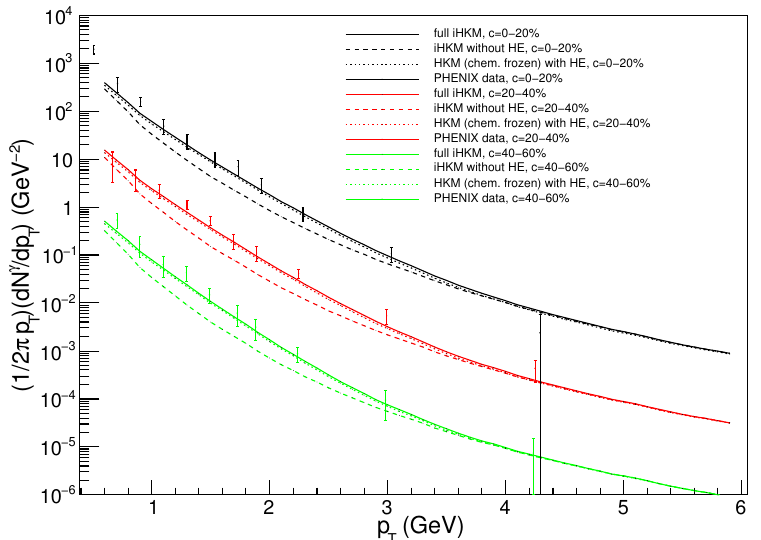
Figure 2. The total direct-photon p T spectra in the top RHIC energy Au+Au collisions, obtained by the summation of the different sets of components: the photon radiation calculated within the iHKM with chemically equilibrated evolution at the final stage of the expansion and with the Hadronization Emission (HE) contribution taken into account; the same as in previous case, but without the HE contribution; the photon radiation from the HKM with the chemically frozen evolution at the hadronic stage together with the contribution from the HE. The results for the three centrality classes, c = 0–20%, c = 20–40%, and c = 40–60% are shown. The spectra for the c = 0–20% centrality class are multiplied by 100, and the spectra for c = 20–40% are multiplied by 10. The experimental points are taken from